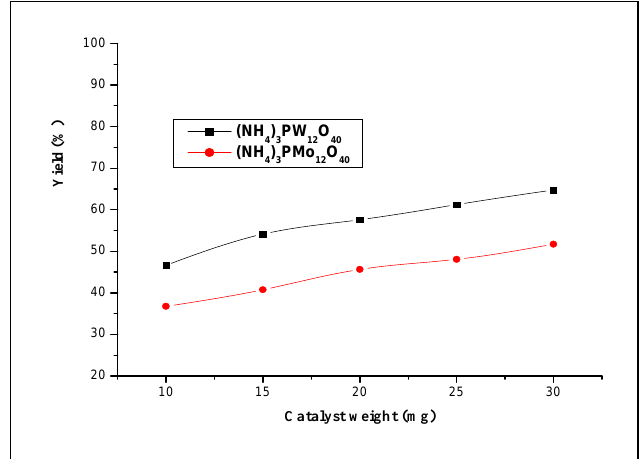
Figure 8. Effect of the amount of catalyst on styrene polymerization (in dichloromethane) using (NH 25 ºC during 12 h.